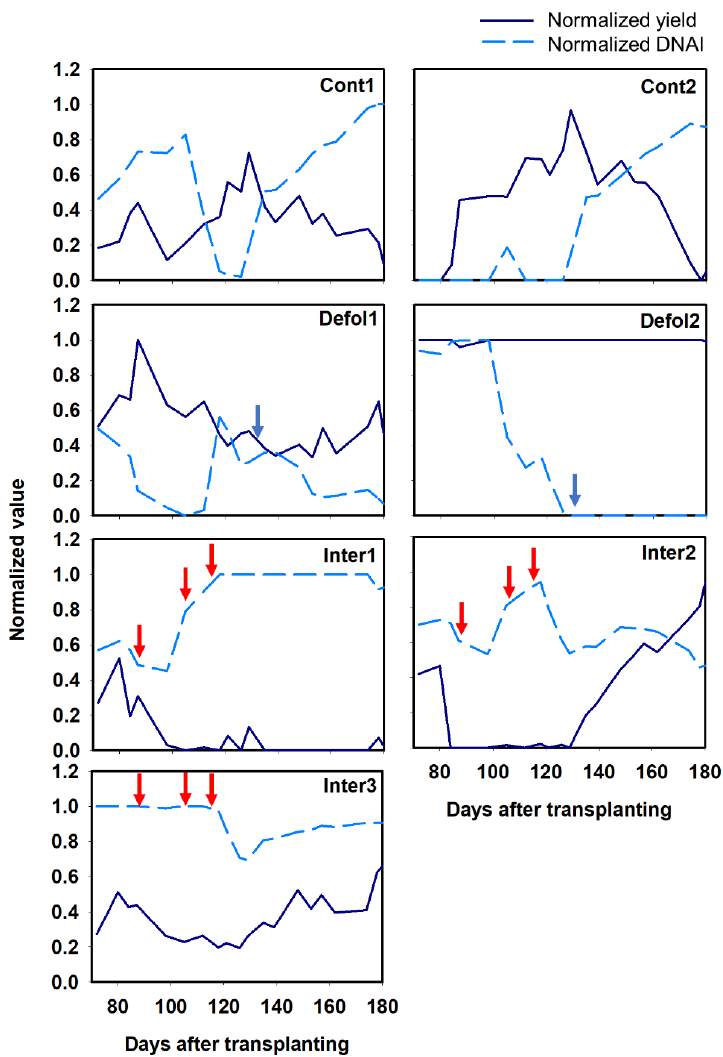
Figure 8. Changes in the normalized value of DNAI and accumulated fruit yield during the period of DNAI estimation experiment; blue arrows in defoliation treatment indicate the initial day of defoliation; red arrows in inter-lighting treatment indicate the initial day of inter-lighting and the subsequent adjustment of inter-lighting operation time.